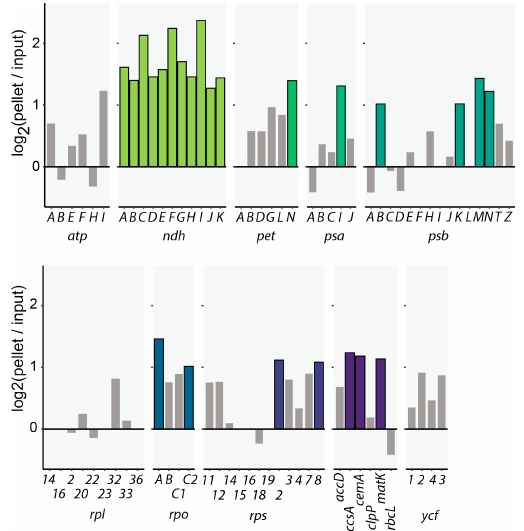
Figure 1. Target RNAs of CP31A identified by DO-RIP-Seq. The enrichment of RNAs in the pellet samples of CP31A over the respective input samples is shown for all protein coding chloroplast genes (based on the TPM normalized and log 2 -transformed read counts for every gene in every sample). Three biological replicates were used. Genes surpassing the cut-off criteria, namely enrichment of ≥ log 2 (1) and ≤ p 0.05 were considered targets. Results for non-target genes were greyed out.